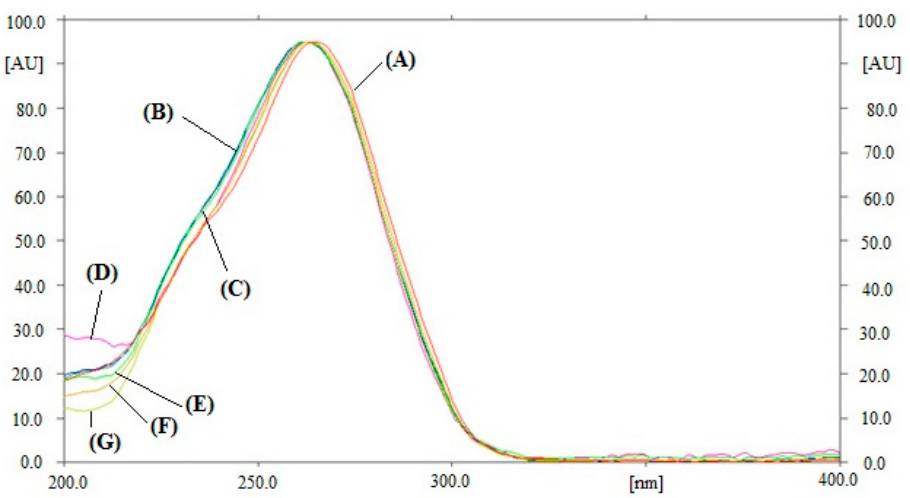
Figure 3. Overlaid UV-absorption spectra of ( A ) standard AA, ( B ) the UAE of P. emblica , ( C ) the SE of P. emblica , ( D ) the UAE of P. guajava , ( E ) the SE of P. guajava , ( F ) the UAE of C. annuum , and ( G ) the SE of C. annuum .